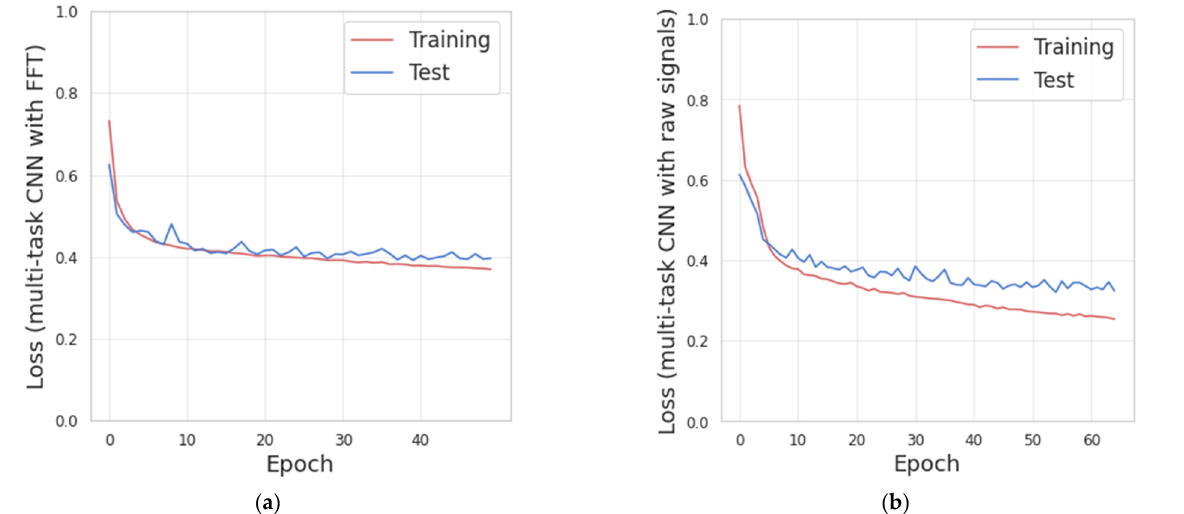
Figure 10. ( a ) Loss curves obtained from the training of multitask CNN with Fast Fourier Transform (FFT). ( b ) Loss curves obtained from the training of the multitask CNN with triaxial signals.